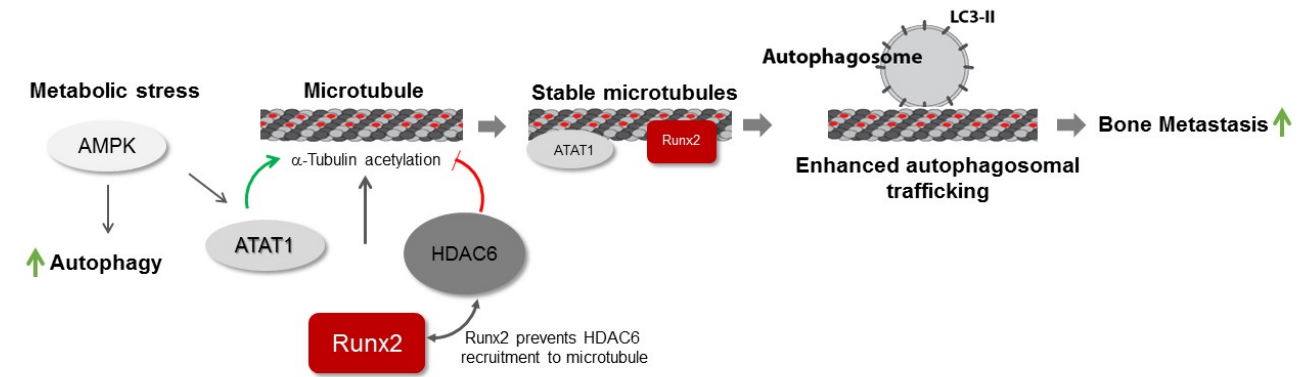
Figure 8. The main factors and pathways contributing to microtubule stability and acetylation in bone metastasis are shown. The AMPK pathway positively regulates autophagy and α -tubulin N-acetyl transferase-1 (ATAT-1). Acetylation of α -tubulin is increased by ATAT-1 and can be reversed by HDAC6. Our results show that Runx2 promotes acetylation of α -tubulin and microtubule stability. We found that Runx2 inhibits HDAC6 interaction with α -tubulin resulting in increased acetylation and stability of microtubules and enhanced autophagy flux. Previous reports show that upregulation of the autophagy pathway supports tumor growth and bone